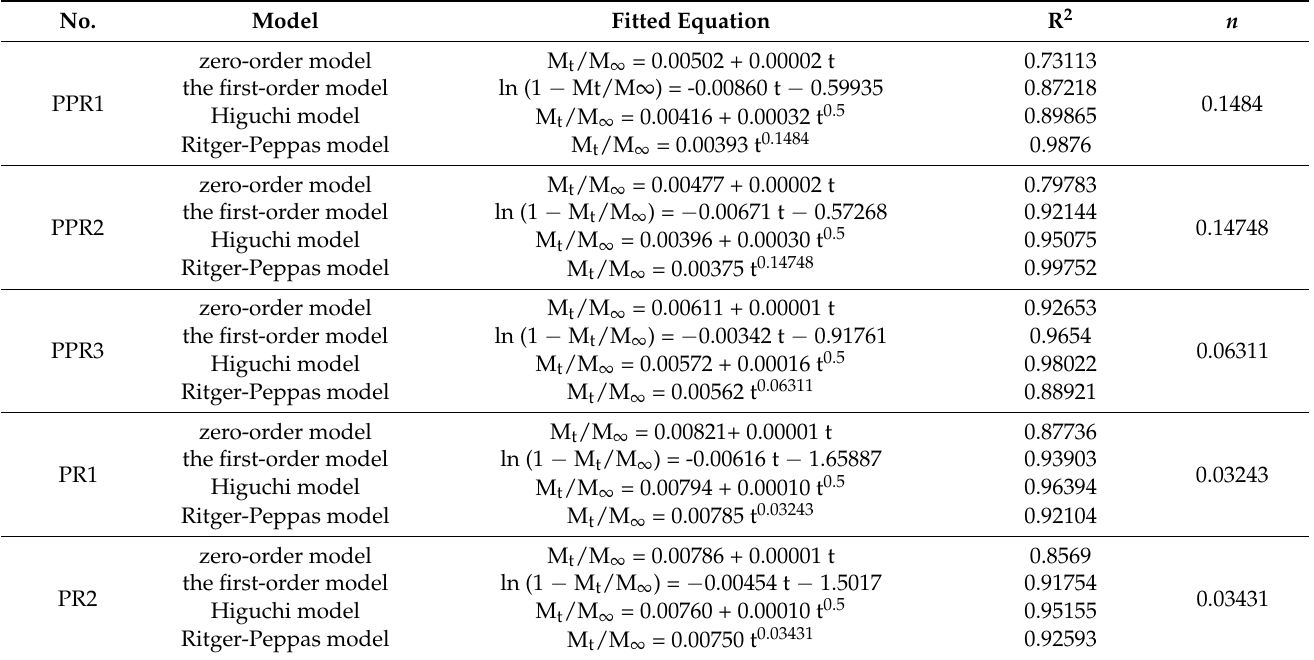
Table 2. Drug release models of the different